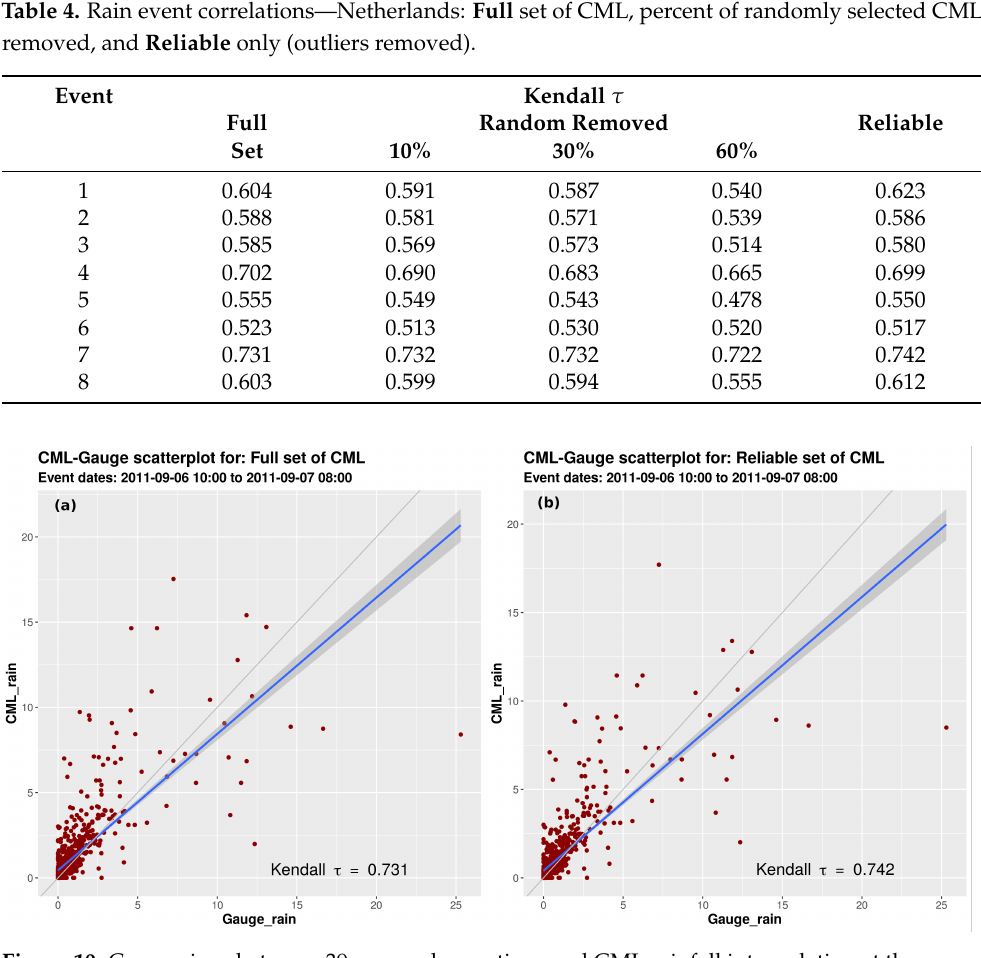
Figure 10. Comparison between 39 gauge observations and CML rainfall interpolation at the gauge locations over a 22-h duration rain event. Scatterplots of both the Full ( a ) and Reliable ( b ) sets of CML are